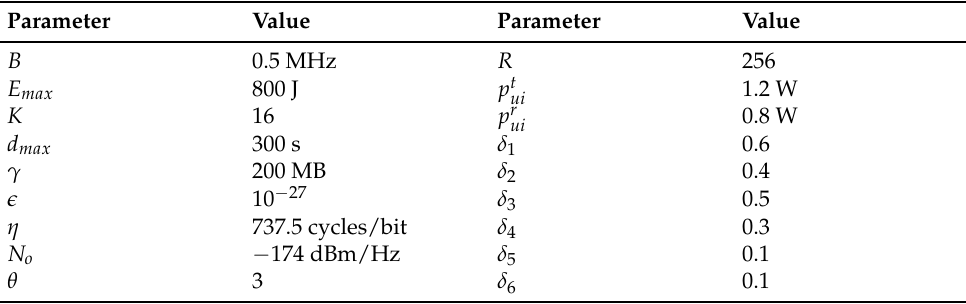
Table 3. Simulation